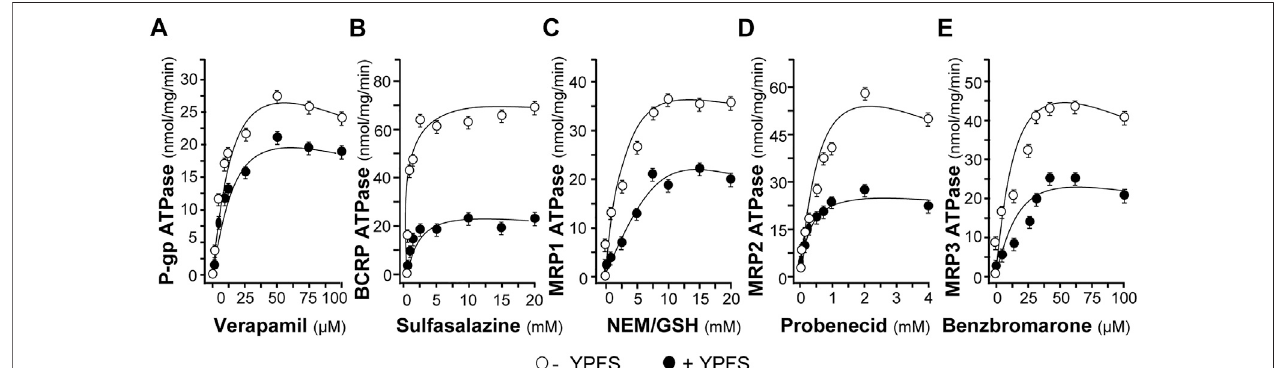
FIGURE4| YPFS suppresses ATPase activity. YPFS suppressed verapamil-stimulatedP-gp ATPase (A) ,sulfasalazine-stimulatedBCRPATPase (B) ,NEM/GSH- stimulated MRP1 ATPase (C) , probenecid-stimulated MRP2 ATPase (D) and benzbromarone-stimulated MRP3 ATPase (E) . The ATPase substrate was added to plasma membranes, with or without 3 mg/ml YPFS, for 5 min. Then, Mg 2+ ATP (4 mM) was treated for further incubation, i.e. 20 min for P-gp, 10 min for BCRP, 60 min for MRP1, 40 min for MRP2 and 60 min for MRP3. An identical reaction mixture containing 0.250 mM NaOV was assayed in parallel. Thus, ATPase activity measured in the presence of NaOV represented non-ATPase activity, and which would be subtracted from the total activity measured in the various samples to yield ATPase activity. Thereaction wasstopped bytheadditionof10%SDSandliberationofinorganicphosphate wasdetected bycolorimetricreactionwithascorbicacidin ammonium molybdate solution. The amount of inorganic phosphate released by 1 mg ATPase within 1 min represents enzyme activity. Mean ± SEM, n (cid:2)